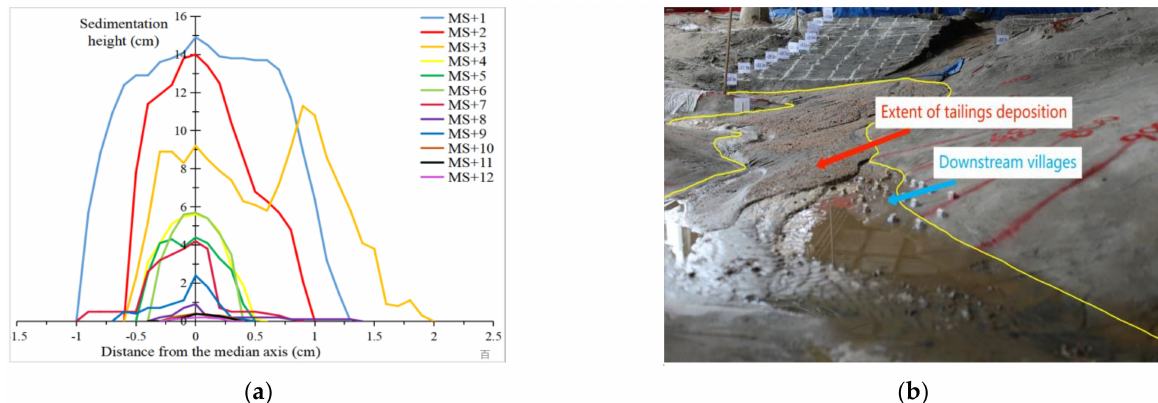
Figure 8. Impact of downstream tailing after dam failure. ( a ) Depth of tailing sand accumulation in each section. ( b ) Range of tailing sand